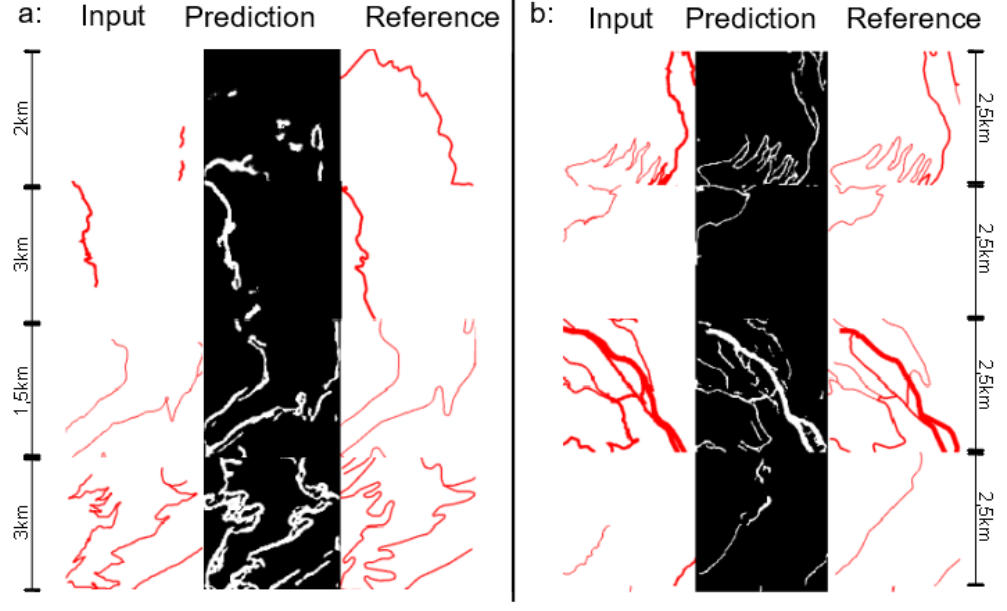
Figure 11. Comparison of results from the different tiling methods. ( a ) Object-based tiles. ( b ) Fixed-size tiles with image size of 2.5 km, overlapping rate of 40% and level of roads represented by their